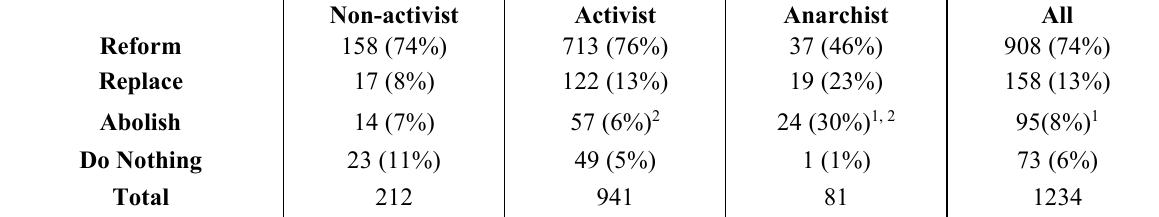
Table 6: Attitudes toward the United Nations 11